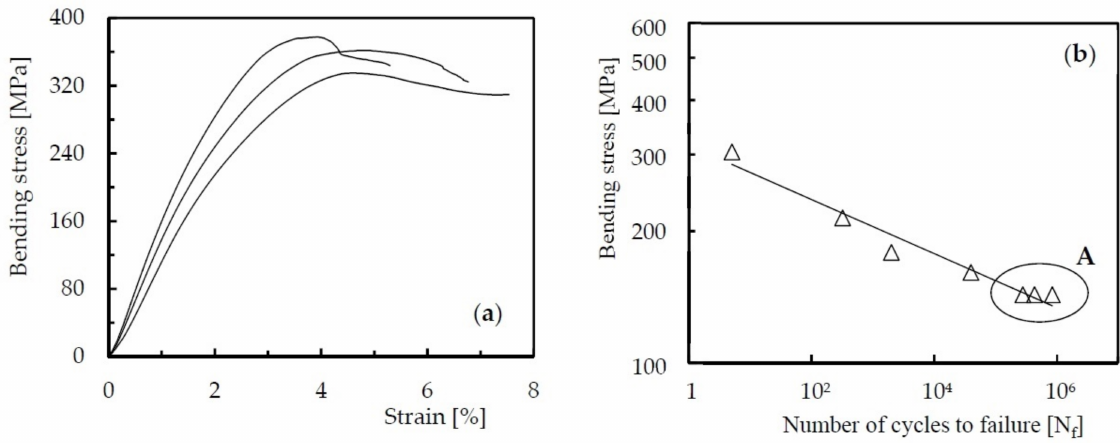
Figure 7. Flexural stress properties ( a ) and SN curve ( b ) for Kevlar/epoxy laminates after an impact of 12